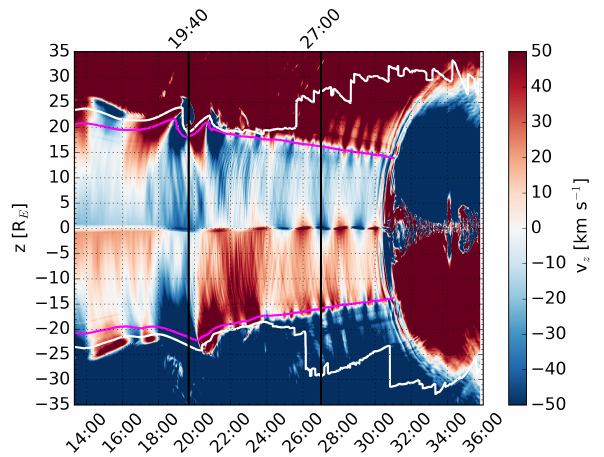
Figure 10. The same as Fig. 8 except that the color shows the mag- netosonic speed ( V ms